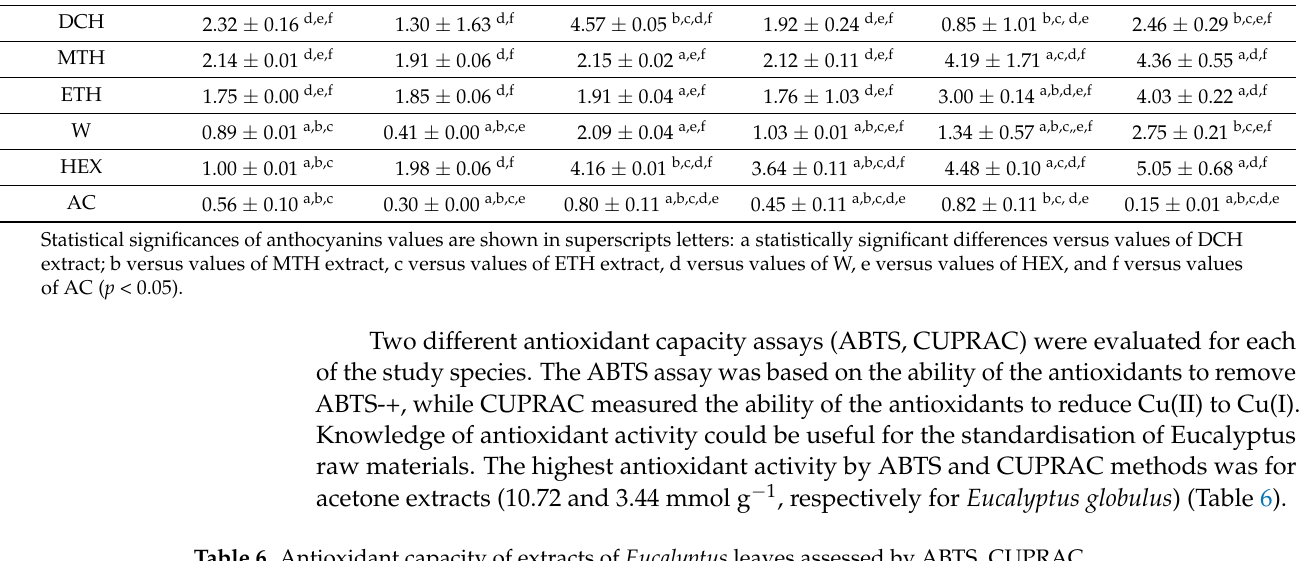
Table 6. Antioxidant capacity of extracts of Eucalyptus leaves assessed by ABTS,